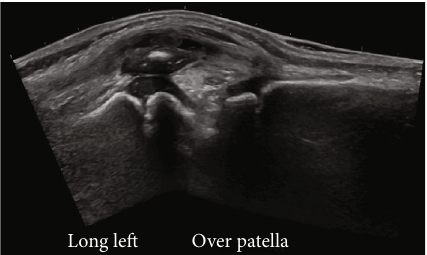
Figure 2: Ultrasound of the a ff ected knee con fi rms a collection of fl uid within the prepatellar